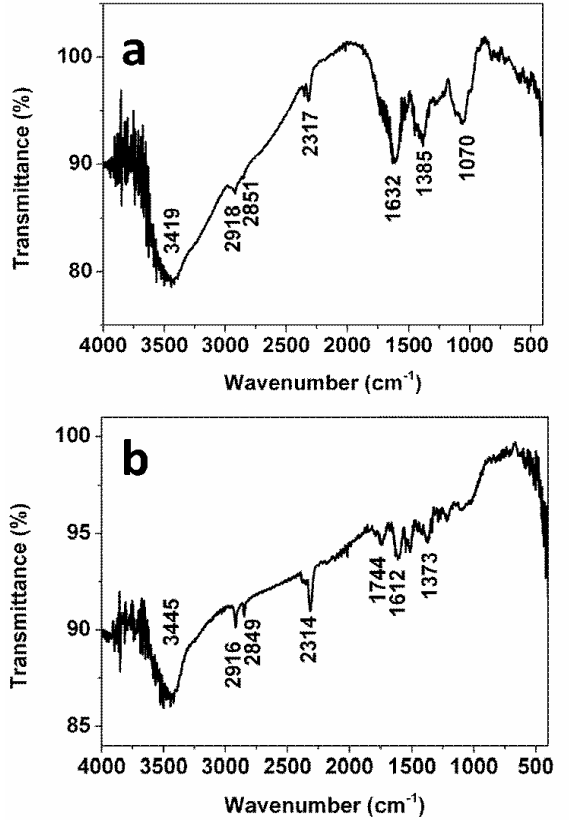
Figure 5. Fourier transform infrared (FTIR) spectra of the extract ( a ) and the obtained Ag nanoparticles ( b